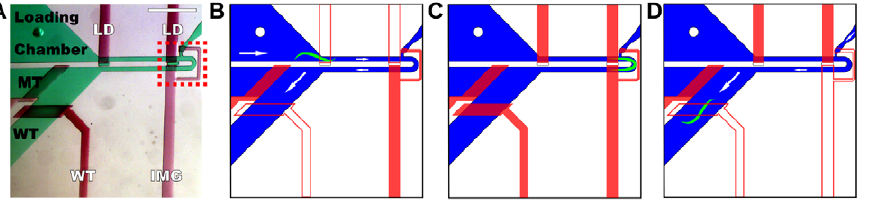
Figure 1. Microfluidic device to passively orient C.elegans for visual screening. (A) Device used for orienting, imaging, and sorting animals. Flow layer is shown in green with black text, valve control layer in red with white text. LD is loading valve, MT is channel for mutant output, and WT is channel (black) and valve (white) for wild-type output. IMG is imaging valve. Not labeled are the mutant valve (right of mutant channel) and flush channel (green area above red box). Input and flush channel fluid flow are controlled off-chip. Imaging area is indicated by red dashed box. Scale bar is 800 m m. (B) Device schematic of valve state during worm loading. Worm is driven into imaging area using positive input pressure to induce fluid flow. Loading valve is not actuated, allowing fluid flow. Imaging valve is actuated to prevent worm from exiting imaging area. Wild-type valve is not actuated to assist in worm loading and to provide an exit should an animal slip past the imaging valve. Mutant valve is actuated to prevent animals from entering mutant output. (C) Device schematic of valve state during analysis. All valves are actuated and input pressure is cut off halting fluid flow. (D) Device schematic of valve state during worm sorting. Example for wild-type sorting is shown. Worm is driven out of the imaging area by positive pressure from the flush channel. Loading valve is actuated to prevent any other animals from entering the imaging area. Imaging valve is not actuated to allow worm exit. Wild-type valve is not actuated to allow worm exit into wild-type output. Mutant valve is actuated to prevent animals from entering mutant output. Mutant and wild-type valve state is reversed when mutant sorting is performed. Fluid flow direction indicated by white arrows and is not proportional to size of arrow. Non-filled and filled red boxes indicate non-actuated and actuated valves respectively.